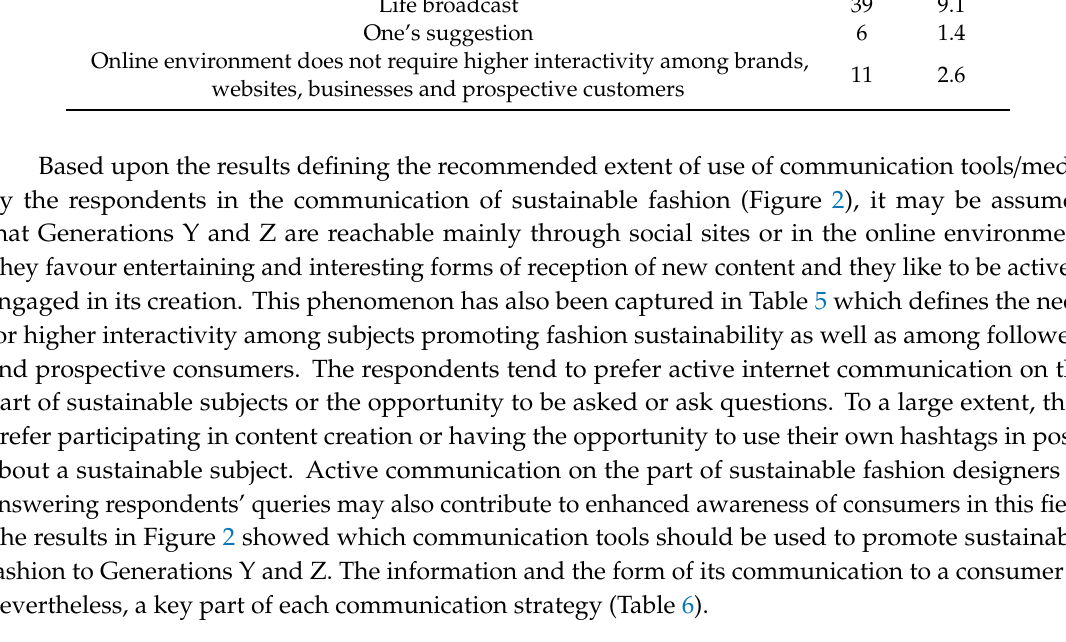
Table 6. Recommended forms of marketing communication of sustainable businesses in the online